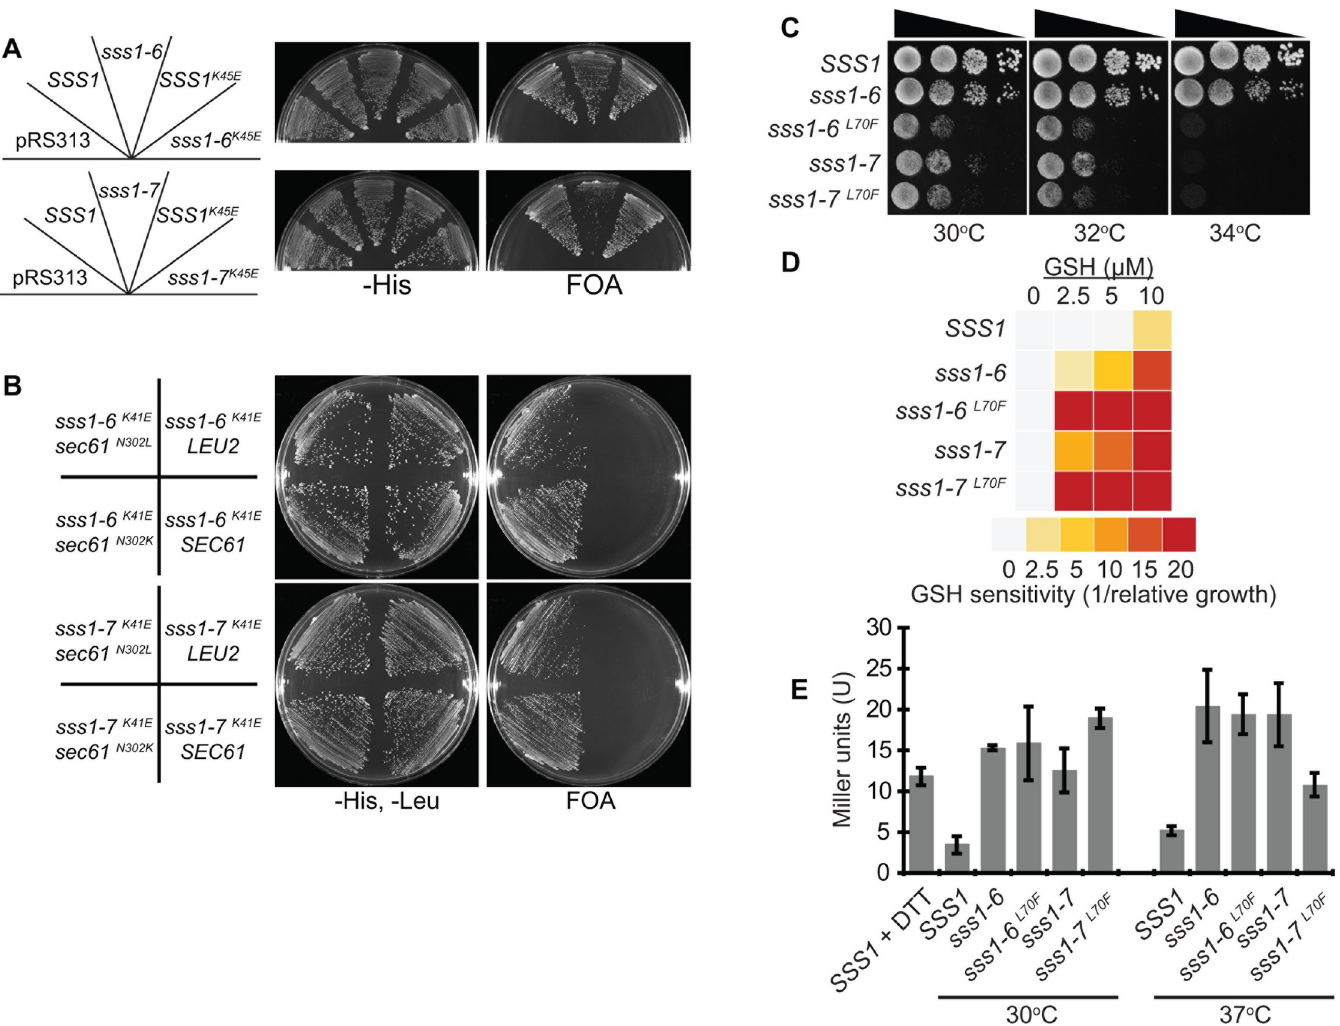
Fig 3. The K27E and L56F mutations destabilise the closed conformation of the translocon. (A) BWY530 yeast transformed with either YCp HIS3 , YCp SSS1 , YCp SSS1 P74A , I75A , YCp SSS1 K41E , P74A , I75A , YCp SSS1 H72K , YCp SSS1 K41E , H72K were streaked onto–His selective medium and medium containing FOA and incubated at 30˚C for 2 days. (B) BWY530 yeast transformed with YCp SSS1 K41E , P74A , I75A and YCp LEU2 , YCp SEC61 , YCp SEC61 N302K or YCp SEC61 N302L or YCp SSS1 K41E , H72KA and YCp LEU2 , YCp SEC61 , YCp SEC61 N302K or YCp SEC61 N302L were streaked onto–His selective medium and medium containing FOA and incubated at 30˚C for 2 days. (C) Wildtype or cells expressing either SSS1 P74A , I75A , SSS1 L70F , P74A , I75A , SSS1 H72K or SSS1 L70F , H72K as the sole source of SSS1 were spotted on YPD agar in a 10-fold dilution series and incubated at 30˚C, 32˚C or 34˚C for 2 days. (D) Wildtype or cells expressing either SSS1 P74A , I75A , SSS1 L70F , P74A , I75A , SSS1 H72K or SSS1 L70F , H72K as the sole source of SSS1 transformed with YEp HGT1 were grown in–Ura selective medium with increasing concentrations of GSH. The relative growth of each strain determined and the GSH sensitivity (1/relative growth) presented. (E) Wildtype or cells expressing either SSS1 P74A , I75A , SSS1 L70F , P74A , I75A , SSS1 H72K or SSS1 L70F , H72K as the sole source of SSS1 transformed with pJT30 (UPRE-LacZ) were grown in–Ura selective medium and β -Galactosidase activity determined. As a positive control wildtype cells were treated with 5mM DTT for 2 hours.